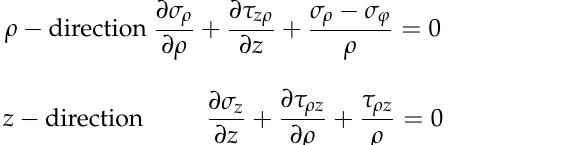
Figure 4. Stress components in cylindrical coordinates.